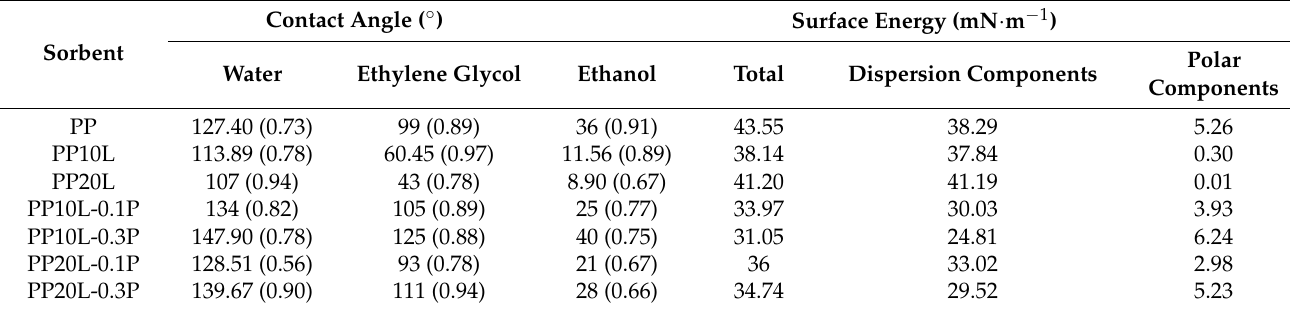
Table 5. The contact angles with water and the surface free energy a